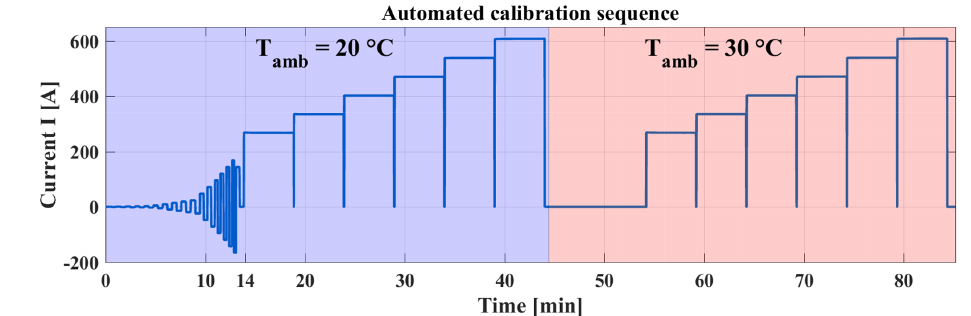
Figure 5. Automated calibration sequence consisting of rectangular current pulses with varying amplitude at two ambient temperatures.